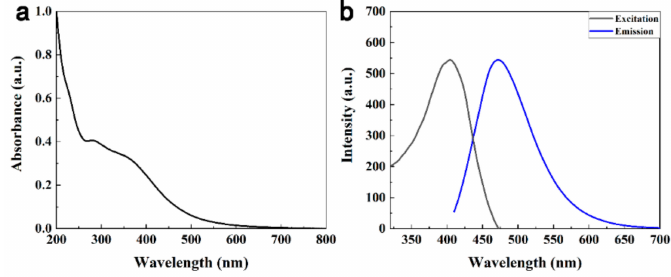
Figure 5. ( a ) UV-vis absorbance and ( b ) FL spectra of